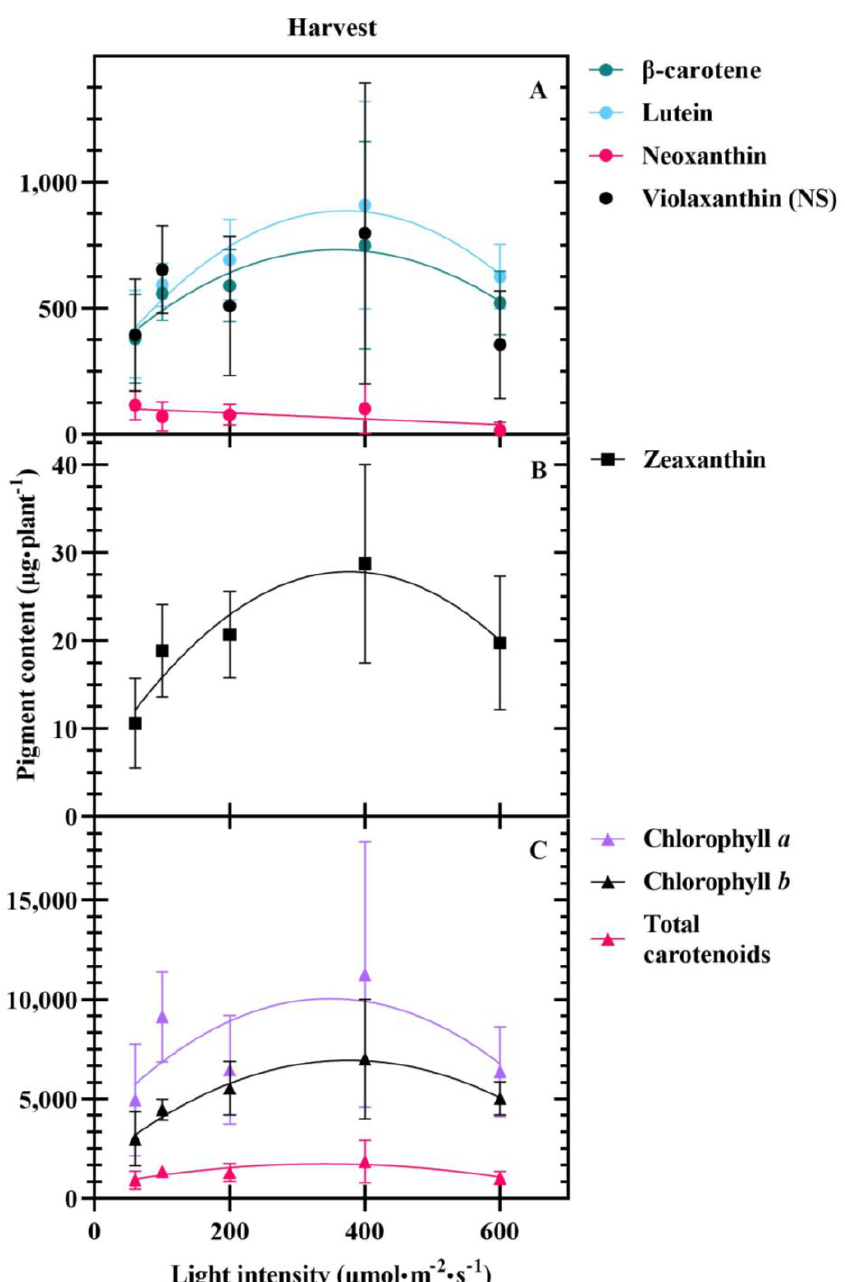
Figure 6. Content ( µ g · plant − 1 ) of β -carotene, lutein, neoxanthin, and violaxanthin ( A ), zeaxanthin ( B ), chlorophyll a and b , and total carotenoids ( C ) of butterhead lettuce ‘Rex’ ( Lactuca sativa ) seedlings grown under light intensities of 60, 100, 200, 400, or 600 µmol·m − 2 ·s − 1 for a 24-h photoperiod for 14 d and then transplanted into a common greenhouse environment and grown for 21 d. Each symbol represents the mean of 12 plants ± SE. Lines represent linear, quadratic, or quadratic plateau regression. Equations and significance are reported in Table 4.